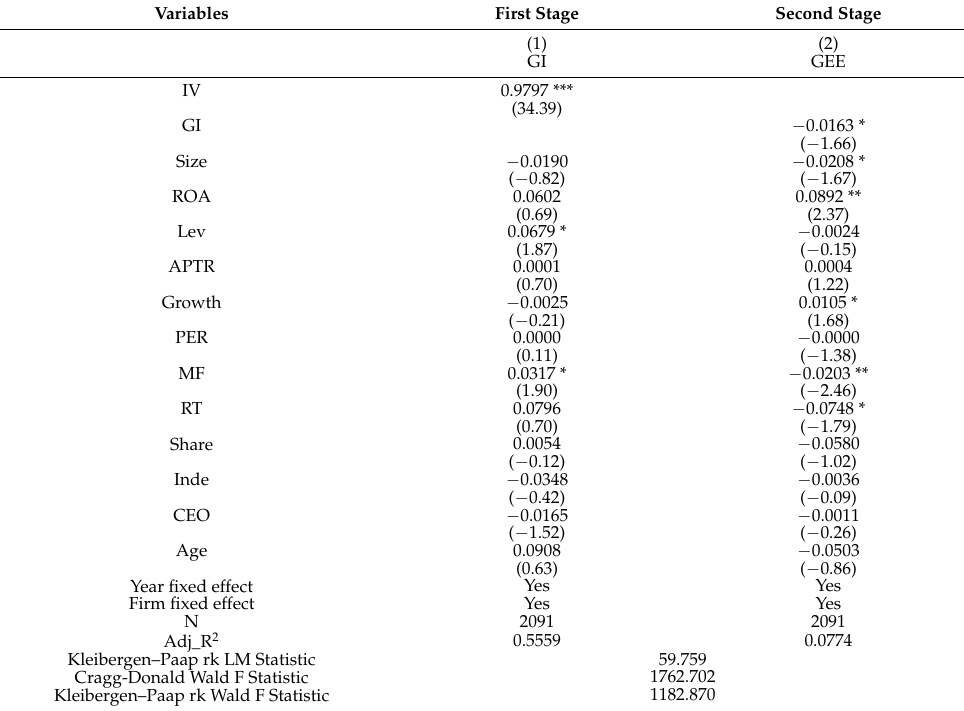
Table A10. Green innovation and green economic efficiency: 2SLS (Full version of column (1)–(2) of Table 4).